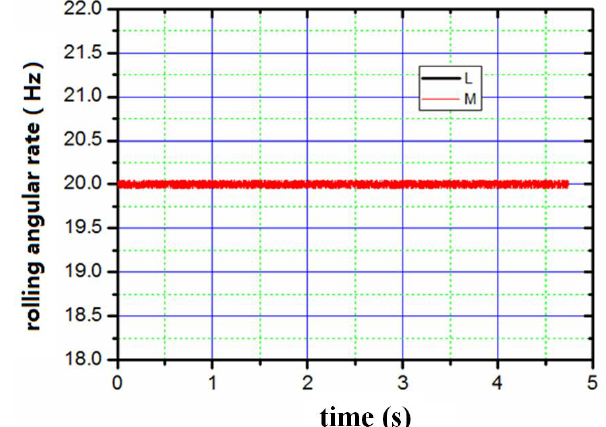
Figure 11. Comparison between the input of rolling angular rate and output of rolling angular rate. L ： the input of rolling angular rate ； M ： the output of rolling angular